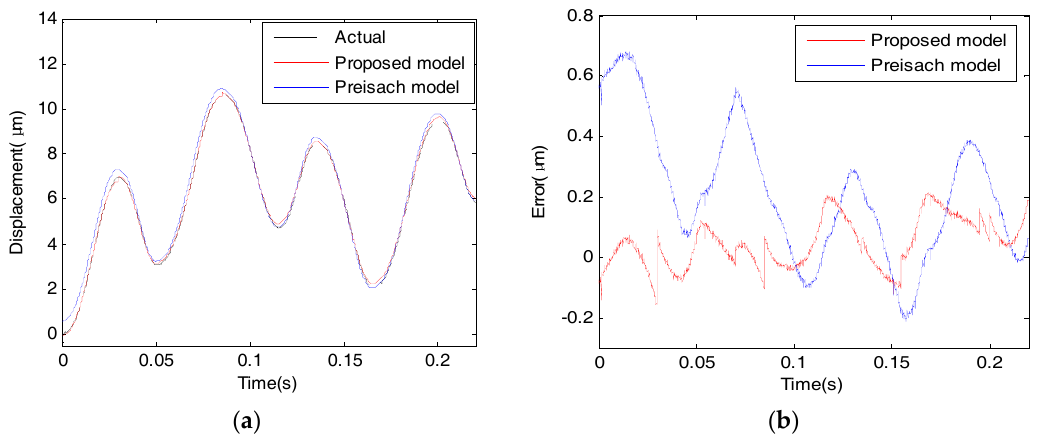
Figure 21. The responses to sinusoidal excitation with high rate. ( a ) Output displacement curves; ( b ) error curves.